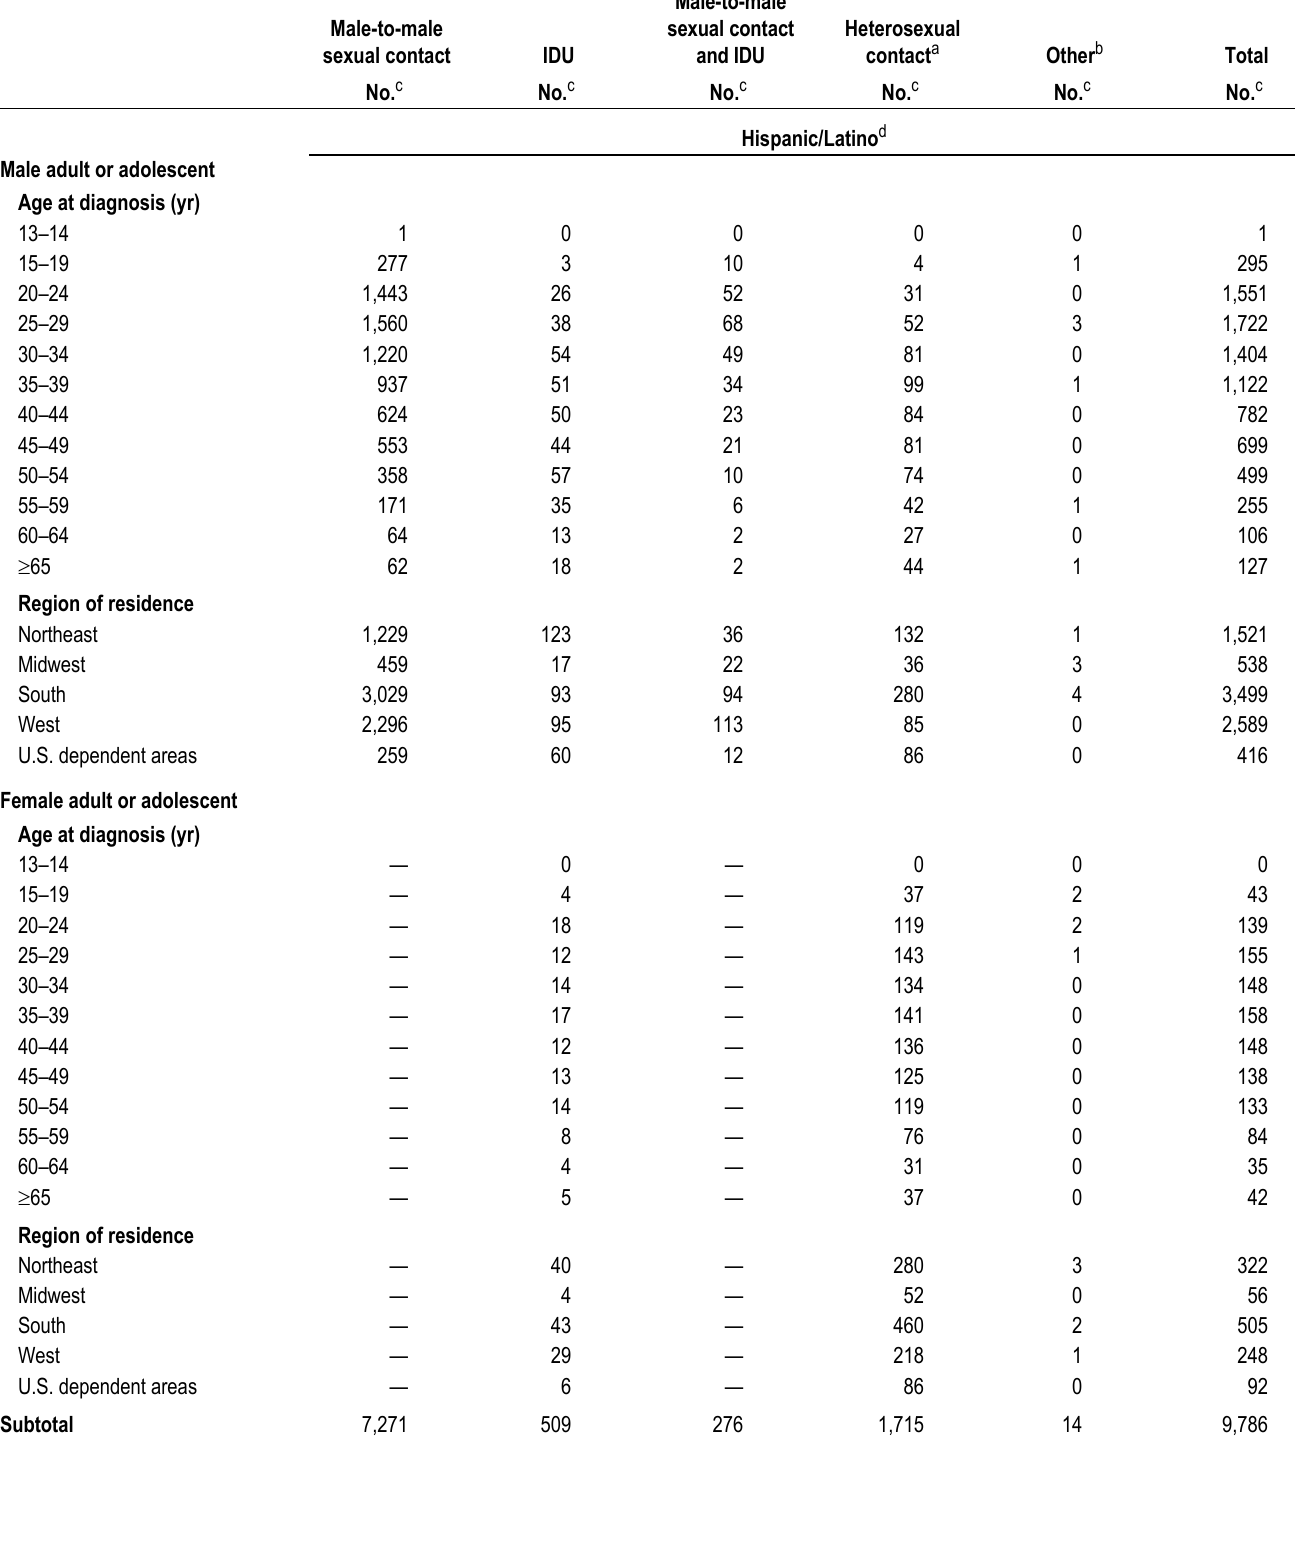
Table 5b. Diagnoses of HIV infection, by transmission category, race/ethnicity, and selected characteristics, 2015—United States and 6 dependent areas